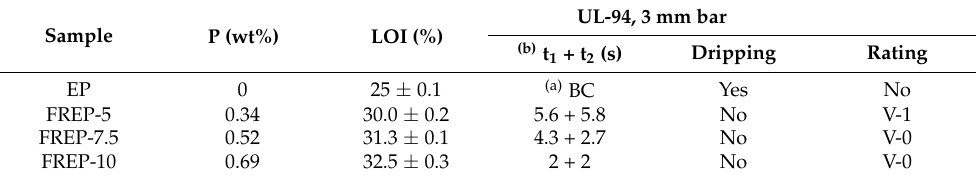
Table 4. UL-94 Flammability Ratings and LOI Values for EP